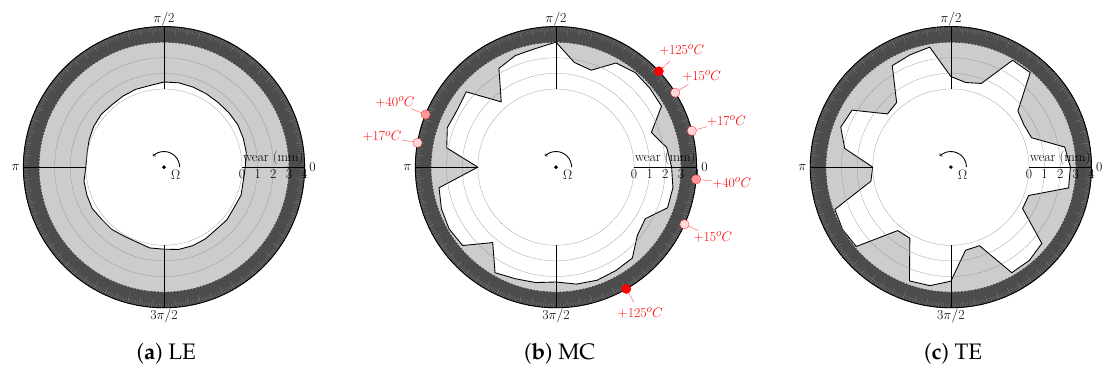
Figure 15. Experimental wear and temperature profiles for the LP compressor test case [2].